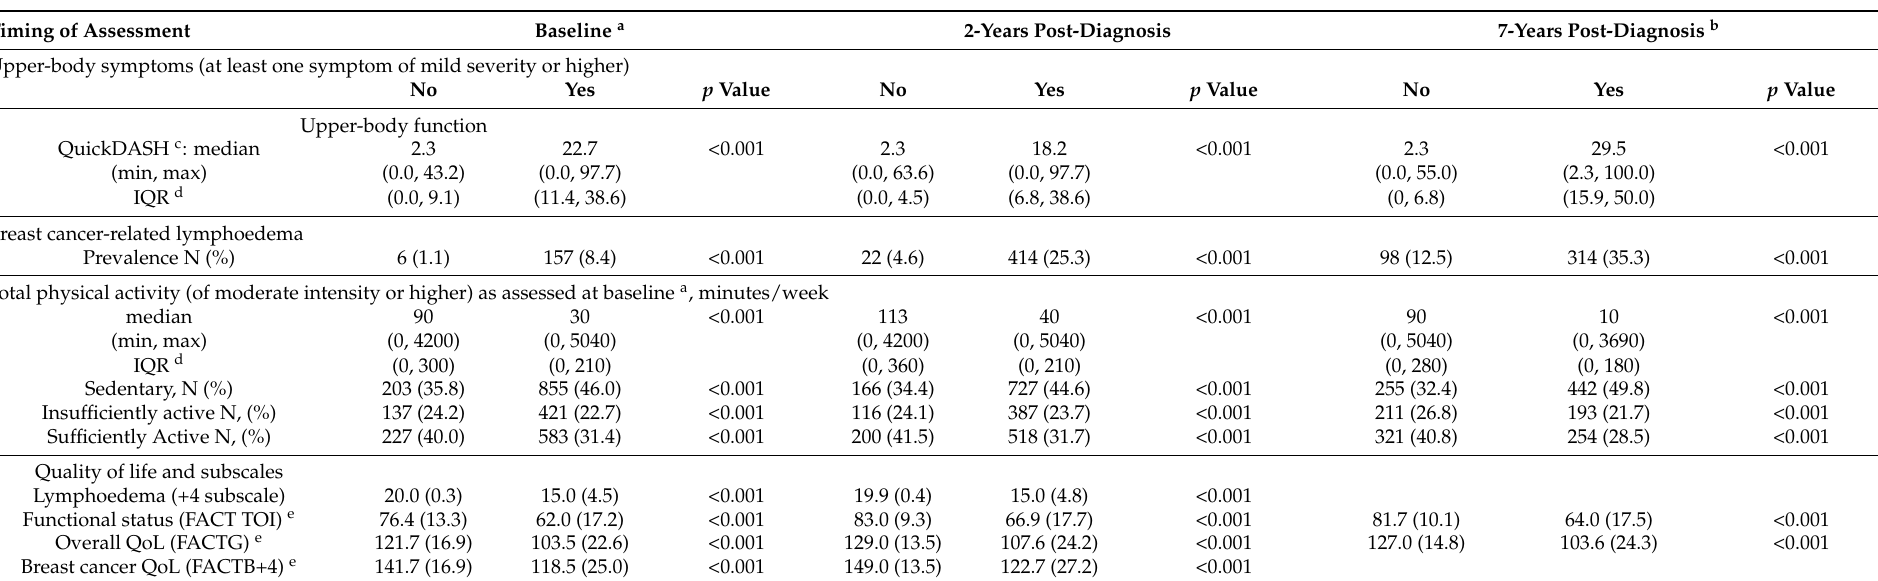
Table 3. Relationships between the upper-body symptoms of at least mild severity and upper-body function, breast cancer-related lymphoedema, physical activity, and quality of life up to 7-years post-diagnosis of breast